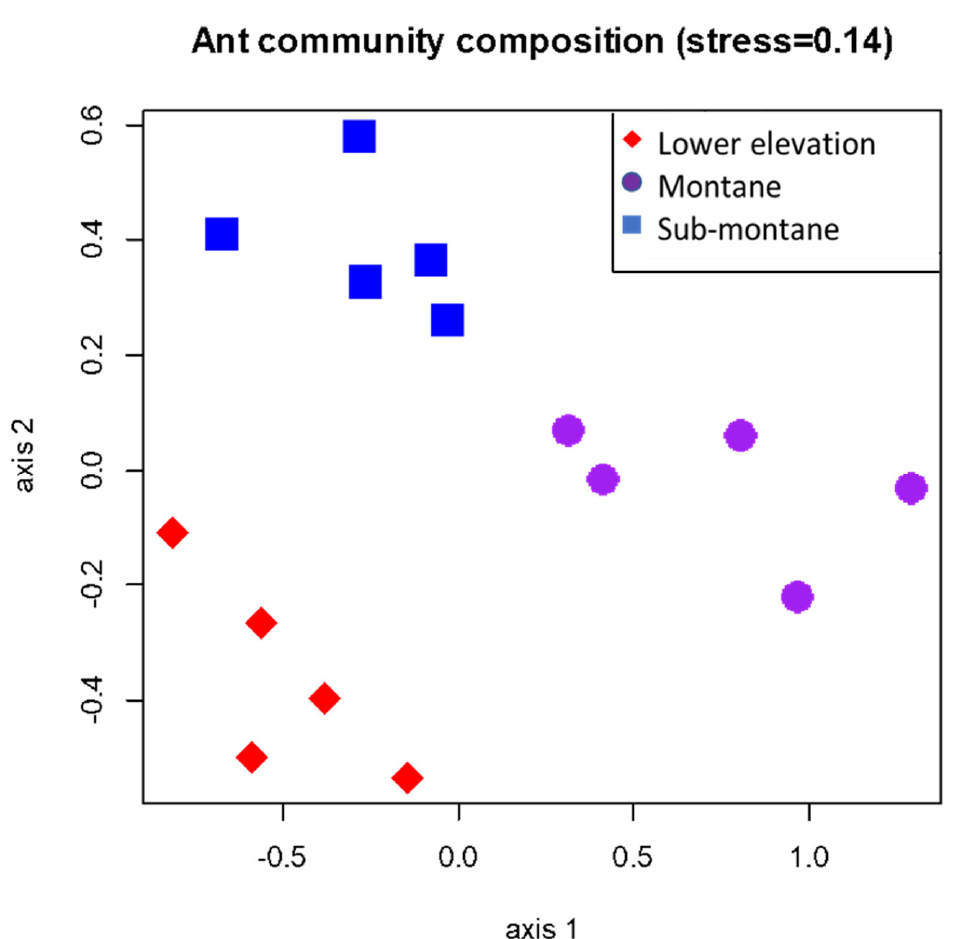
Figure 1. Non-metric multidimensional scaling (NDMS) of community similarity (Bray–Curtis dissimilarity index) based on ant species found in three forests types—lower elevation (red), sub-montane (purple), and montane (blue)—in the Udzungwa Mountains, Tanzania.